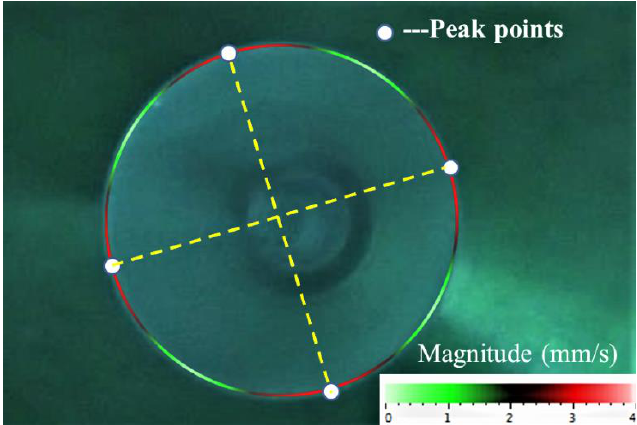
Figure 7. Vibration pattern of the n = 2 resonant mode. The four white dots denote the measurement points with the largest vibration velocities, which in the end indicate the etching position to start with. The annotation of the lower right corner shows different magnitudes of vibration velocity.